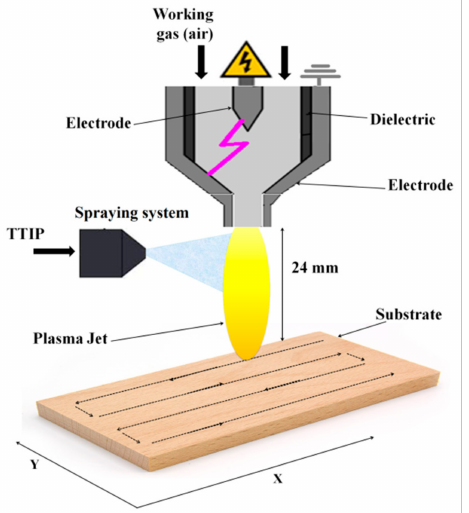
Figure 1. Schematic representation of the atmospheric pressure plasma jet (APPJ) system coupled with spraying system.